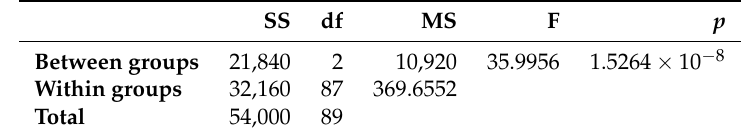
Figure 7. Task 4-moving through an YouTube video using three different haptic technologies: ( a ) distribution per treatment, ( b ) mean and standard deviation, ( c ) evaluation function of users’ age. Table 5. Kruskal Wallis test for Task4.